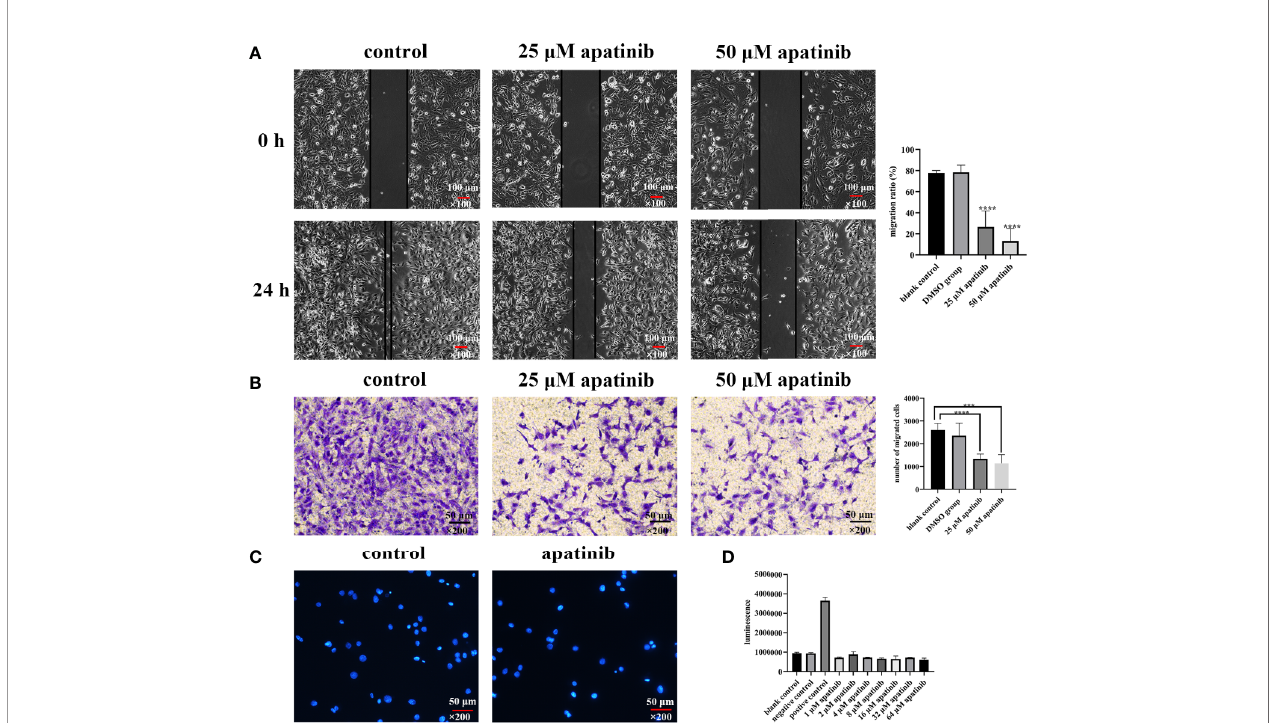
FIGURE 3 | Apatinib inhibits the migration but does not induce apoptosis of malignant peritoneal mesothelioma (MPM) cells in vitro . (A) Scratch wound healing assays showed that apatinib signi fi cantly inhibited MPM cells migration (**** P < 0.0001), magni fi cation, ×100. (B) Transwell assay found that apatinib reduced the number of cells penetrating the membrane, as compared with control groups (*** P < 0.001, **** P < 0.0001), magni fi cation, ×200. (C, D) Apatinib did not induce excessive apoptosis of MPM cells, as con fi rmed by DAPI staining and Caspase-3 assays, magni fi cation,